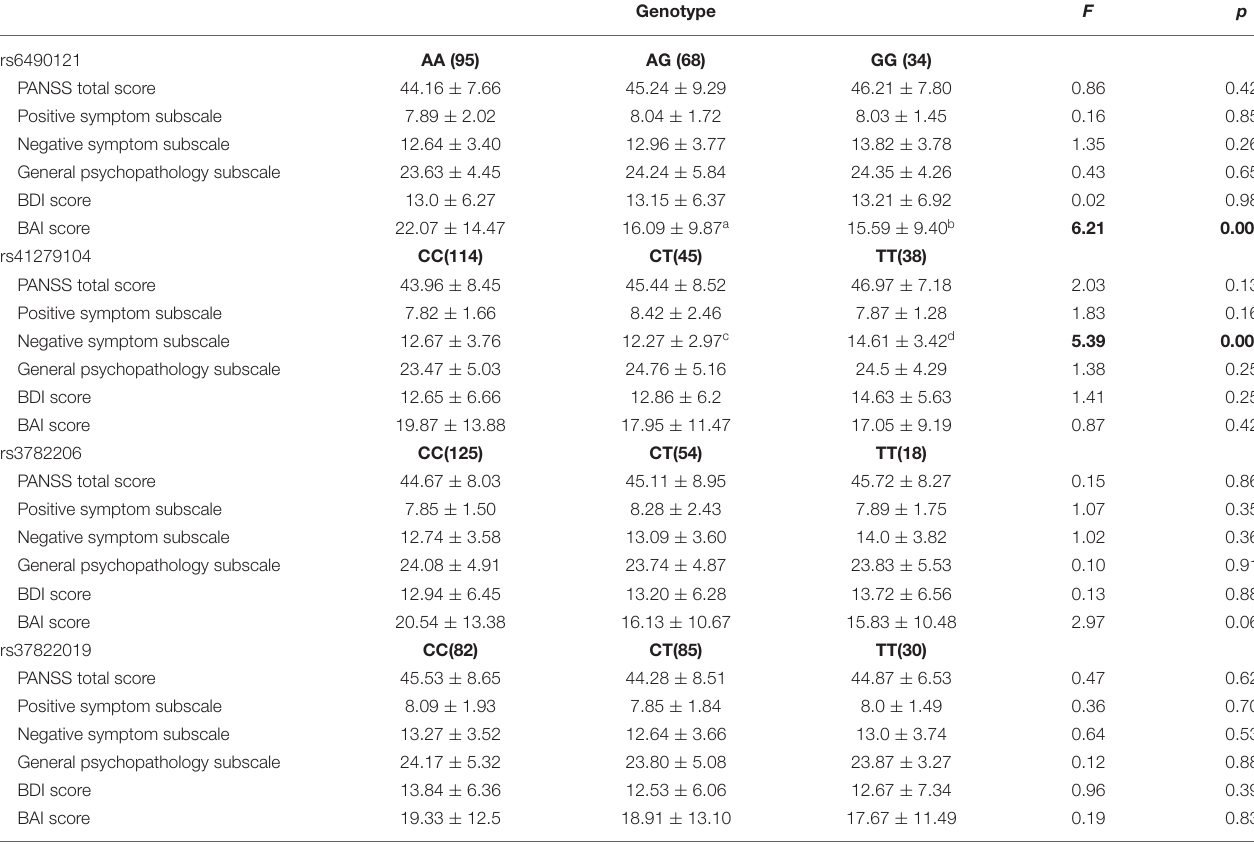
TABLE 4 | Association between psychotic symptom measures and genotypes of four NOS1 SNPs in ketamine users. Genotype F